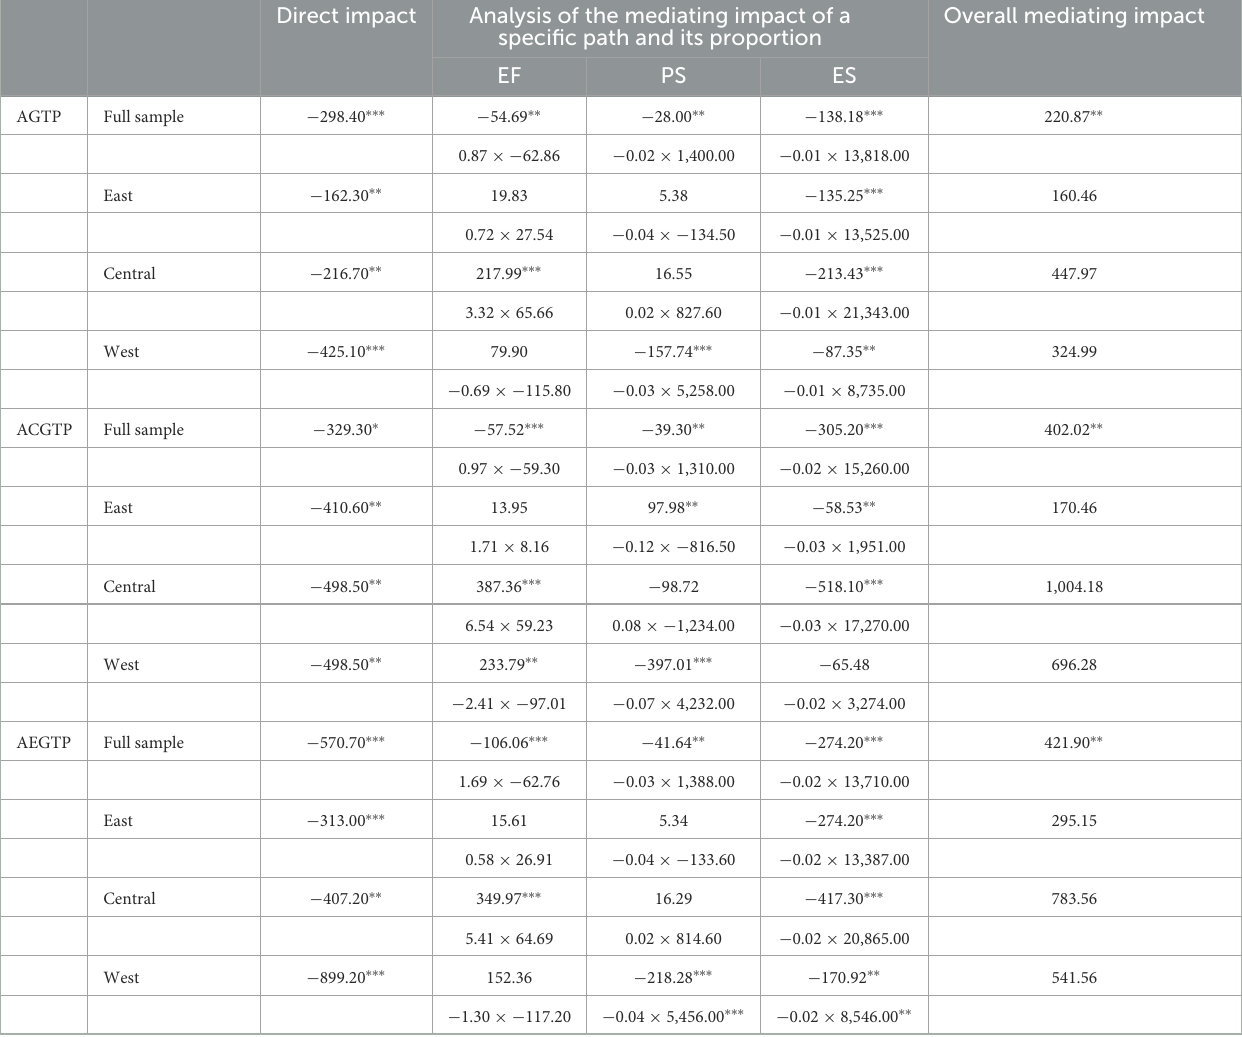
TABLE 5 Analysis of the mediating impact of AGTP, AcGTP, and AeGTP on carbon in the whole sample and sub-zones. Direct impact Analysis of the mediating impact of a Overall mediating specific path and its proportion